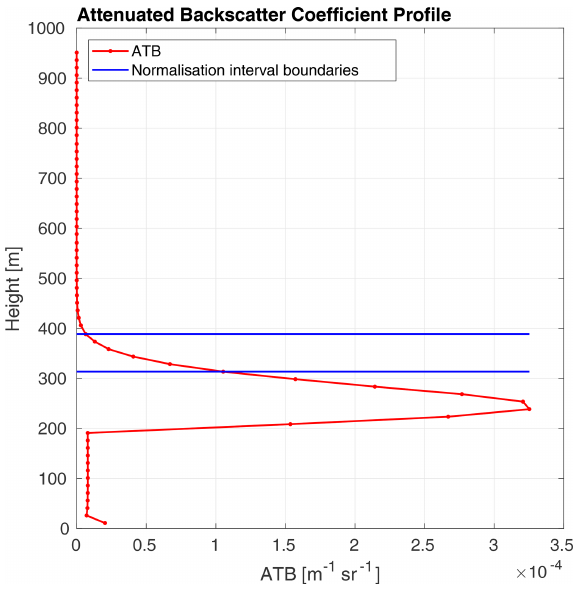
Figure 3. Profile of the ATB and boundaries of the normalisation interval. parts of the cloud. The first four bins within the cloud (up to 60 m within the cloud) are only affected by a mean error in- crease of 3 %. If the SNR is below 20, then the normalisation interval has to be set at a lower